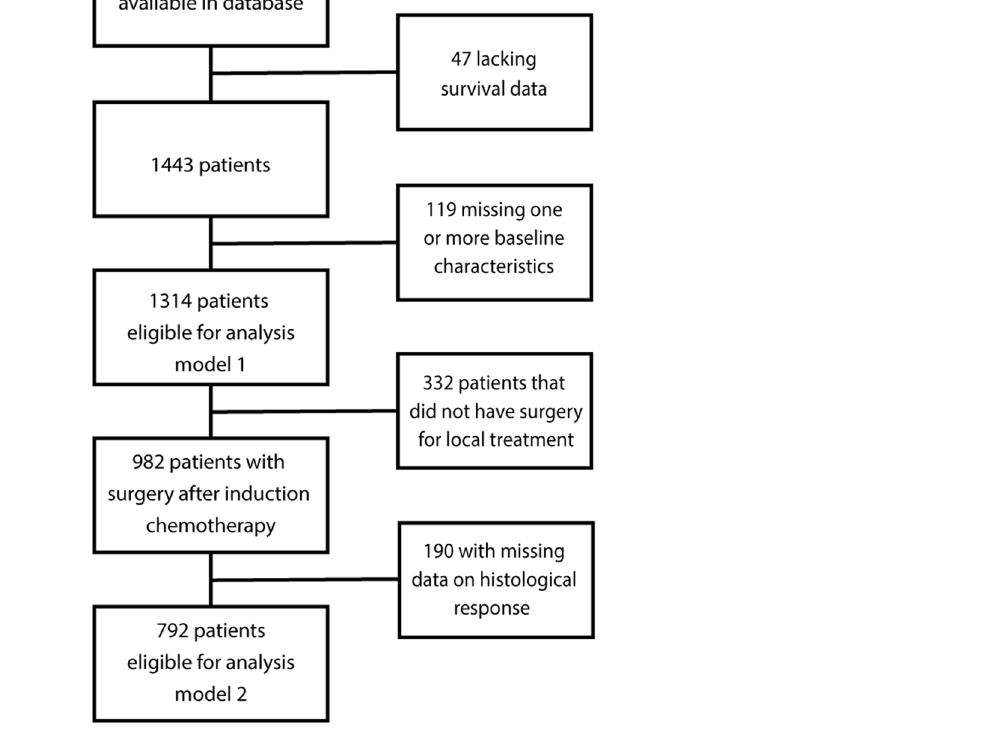
Figure 1. Flowchart